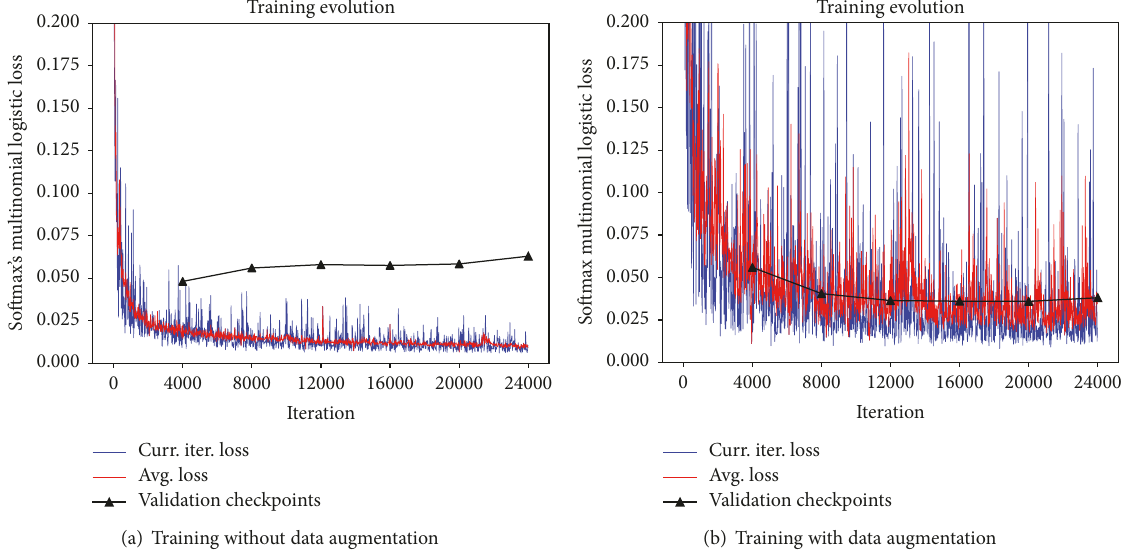
Figure 6: Comparison of the training and validation losses without data augmentation and with data augmentation.